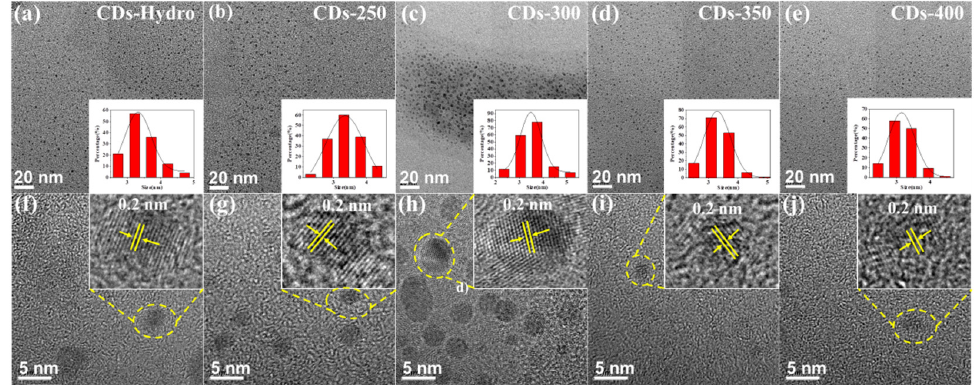
Figure 5. ( a – e ) TEM images of CDs-Hydro, CDs-250 to CDs-400, inset: histograms and Gaussian fittings of particle size distribution. ( f – j ) HR-TEM images of CDs-Hydro, CDs-250 to CDs-400.